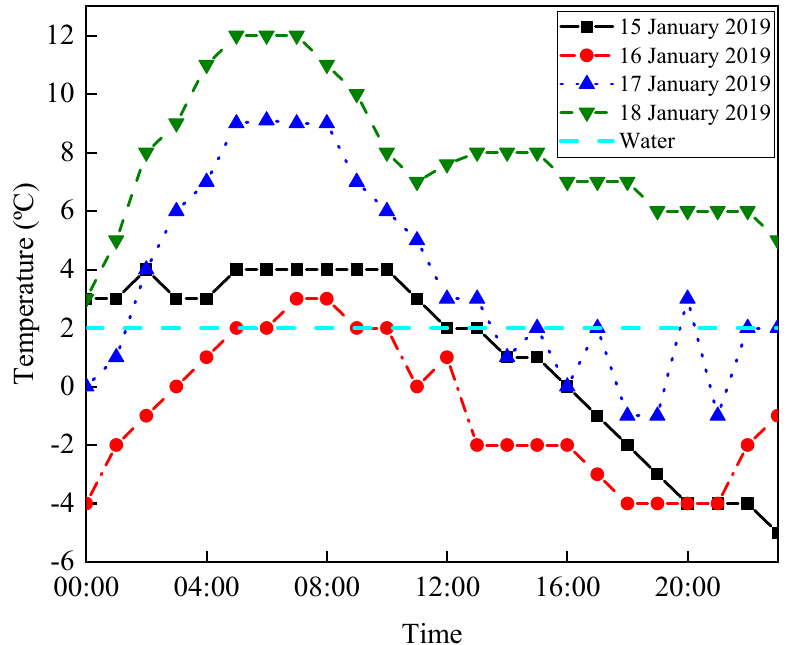
Figure 5. Hourly air temperature in winter (data from NOAA, see: https://gis.ncdc.noaa.gov/maps/ncei/cdo/hourly).